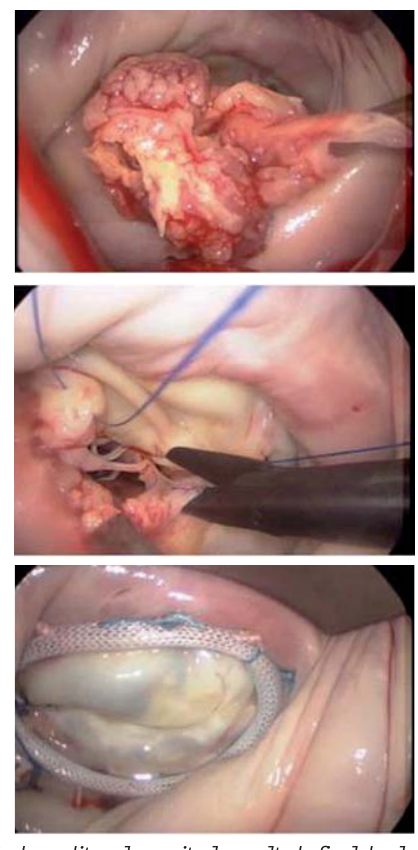
Fig 4 - Endocardite valvar mitral: resultado final da plastia valvar Quatro (3,9%) pacientes apresentaram derrame